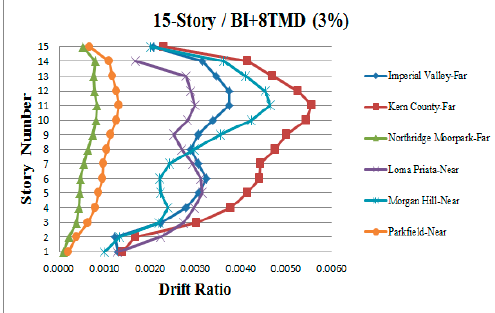
Figure A34. Drift ratios for 15-story base-isolated building with 8 TMDs.